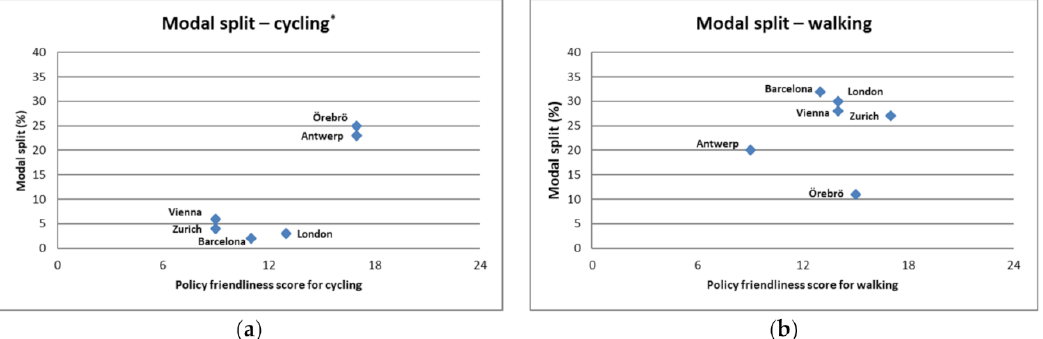
Figure 3. Correlation of the scoring of the policy friendliness score with the modal split of cycling or walking, measured as percentage of the total transport volume, * = p < 0.05. ( a ) Correlation between modal split and policy friendliness score on cycling (r = 0.89, p = 0.006 *); ( b ) Correlation between modal split and the policy friendliness score on walking (r = 0.333, p =